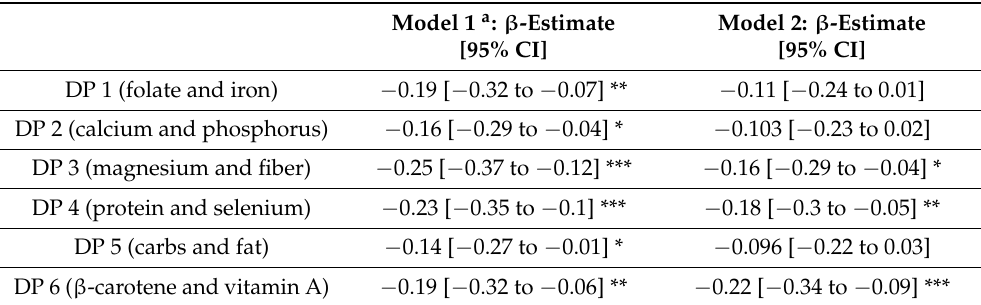
Table 3. Multivariable linear regression analyses examining the association between dietary patterns and olfactory function.